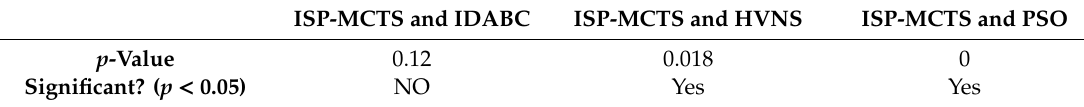
Table 8. Comparison results for the ten harder